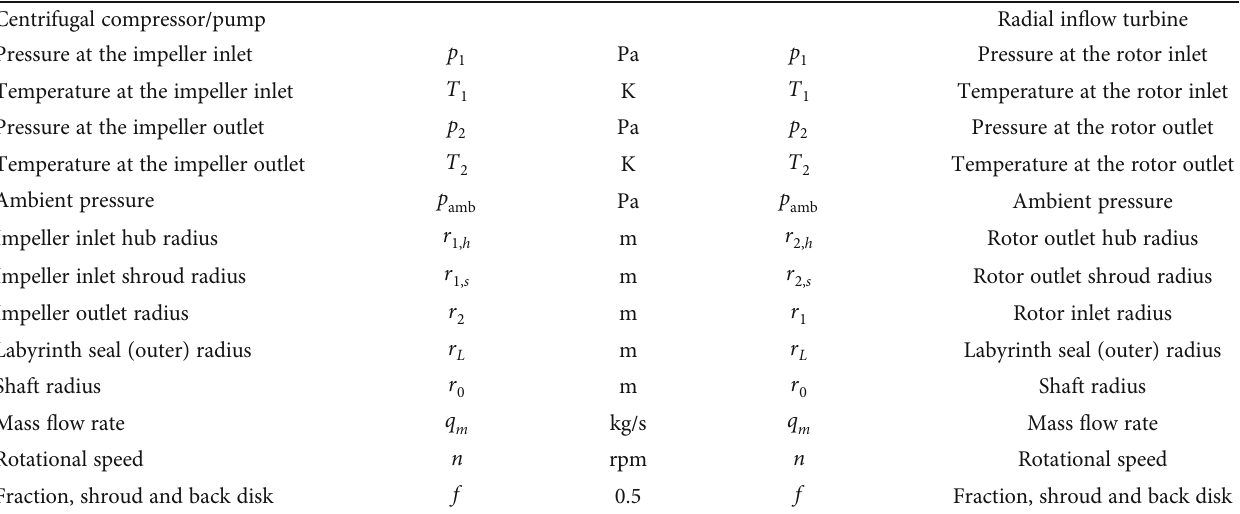
Table 9: Parameters required for the hybrid method.